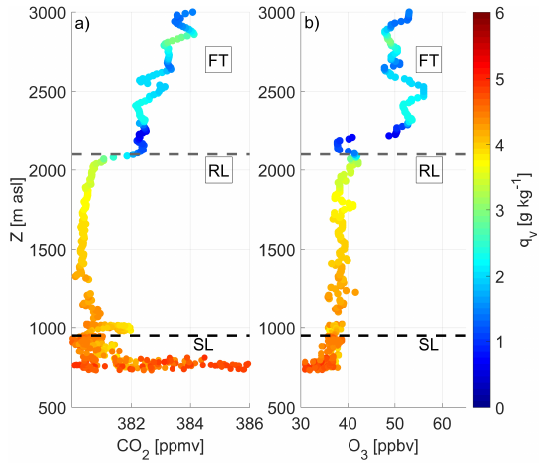
Figure 8. Same as Fig. 7 at noon. The measurement points between 1640 and 2200ma . s . l . are influenced by mixing from the PBL and the